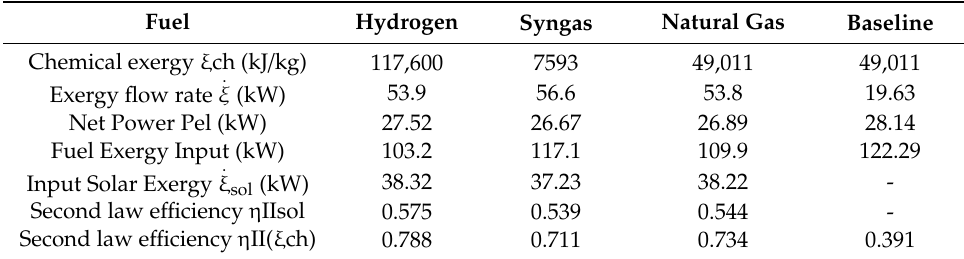
Table 7. Mean exergy flow rate in a year.